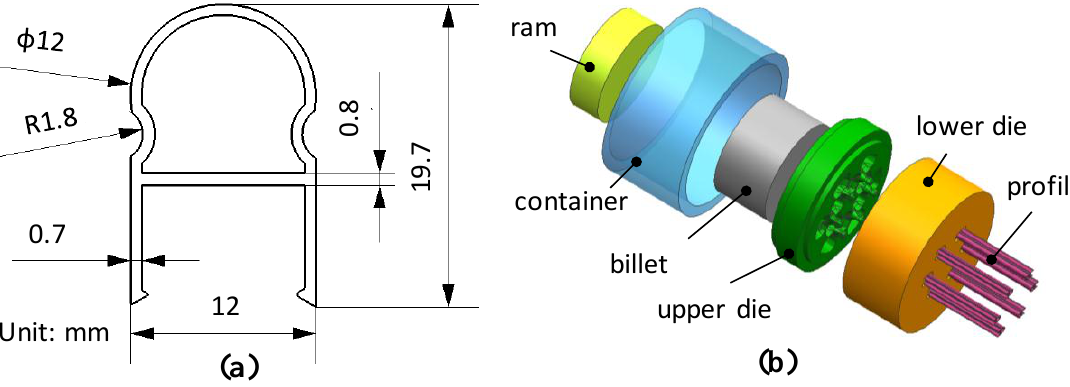
Figure 1. ( a ) Geometry of thin-walled profile; ( b ) die configuration for multi-output porthole extrusion.